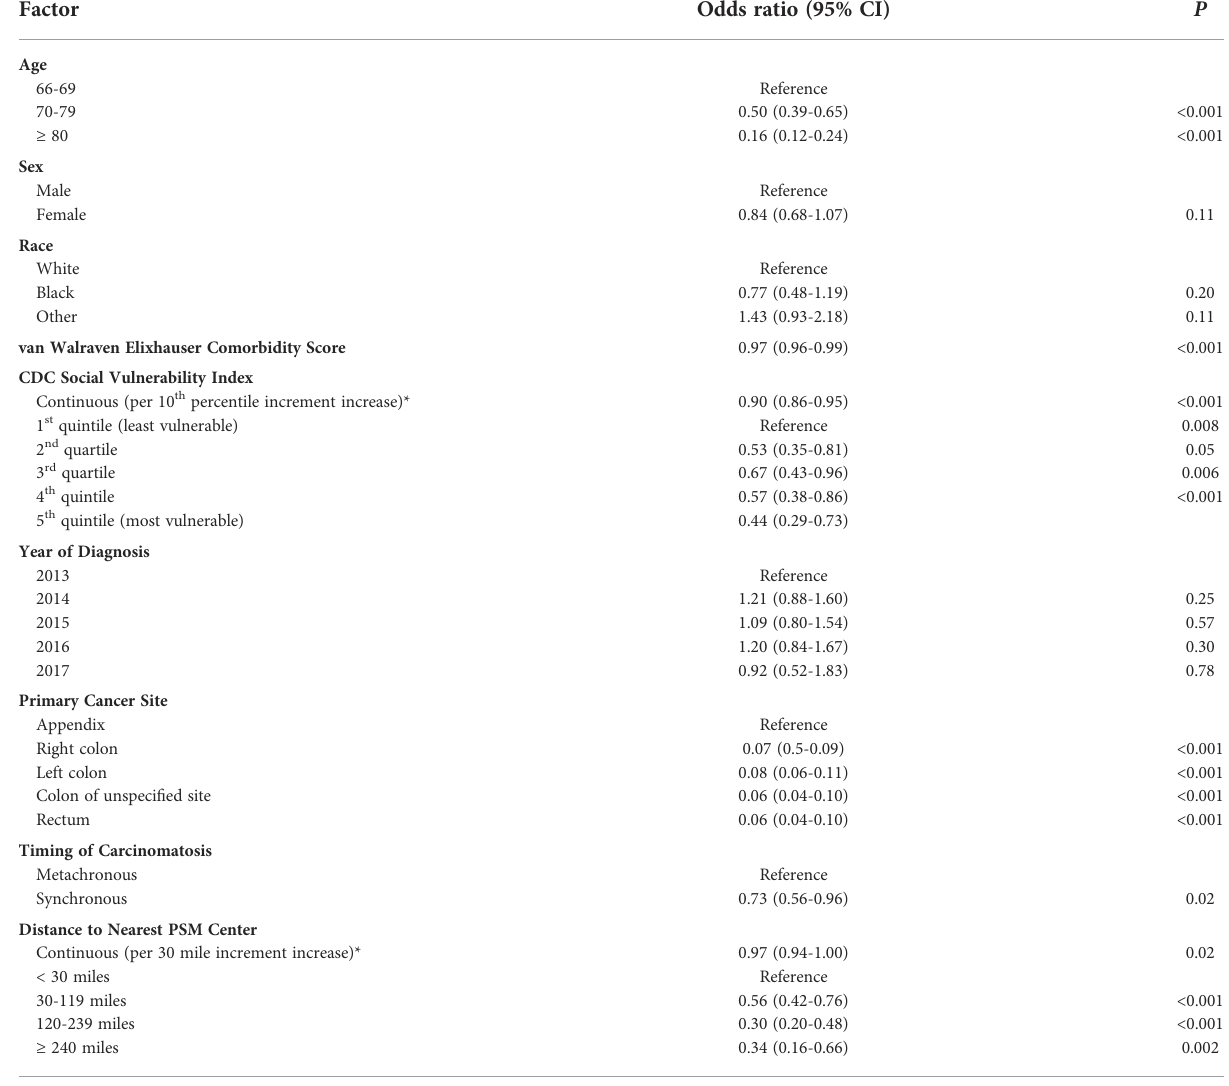
TABLE 3 Mixed-effects multivariable analysis of factors associated with an outpatient visit with a peritoneal surface malignancy (PSM) surgeon.